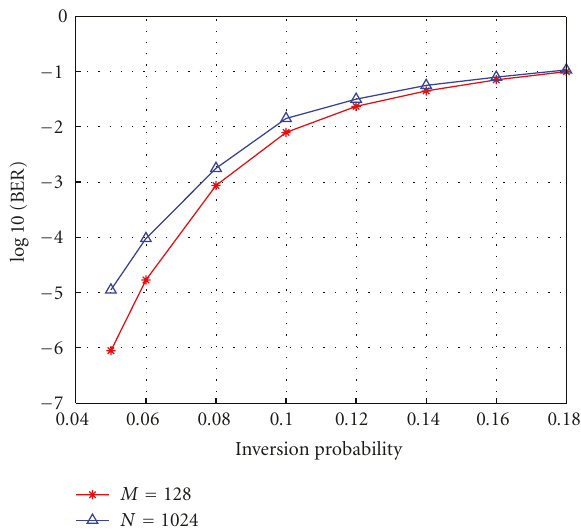
Figure 10: M = 128 LDPC-CC and N = 1024 LDPC-BC BER performance over the same GE